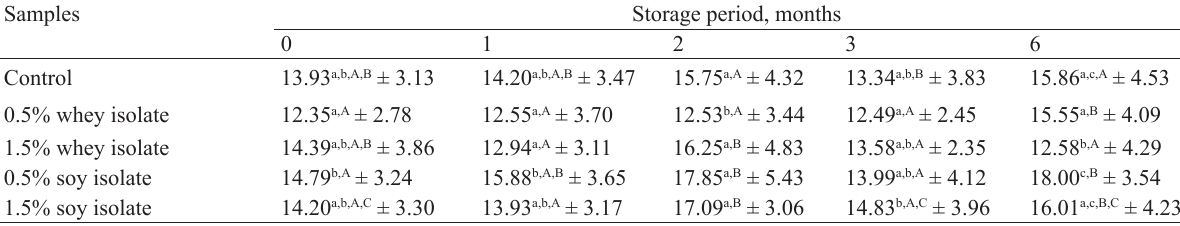
Table 6 b * values of sausages with protein isolates during storage (average ± SD)